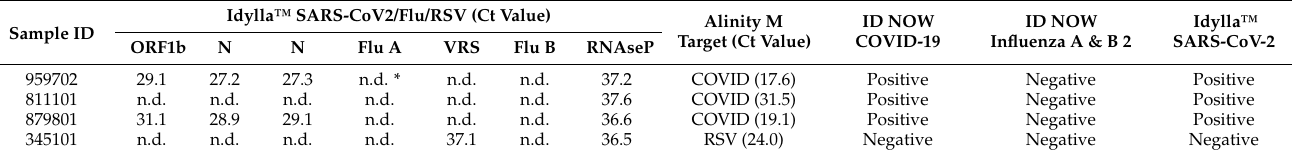
Table 4. Results for the four samples displaying a Ct value > 35.0 for the RNAseP gene but positive for a respiratory virus with the Alinity